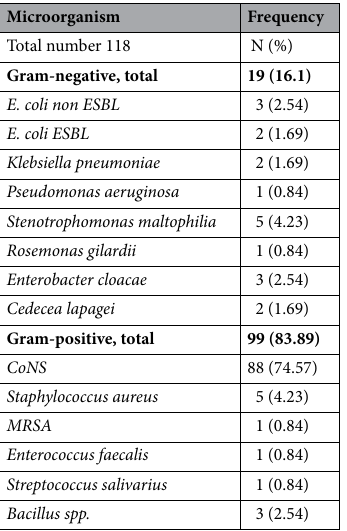
Table 3. Frequency and percentage of isolated microorganisms. ESBL extended spectrum beta-lactamase, CoNS coagulase-negative staphylococci, MRSA methicillin-sensitive Staphylococcus aureus.